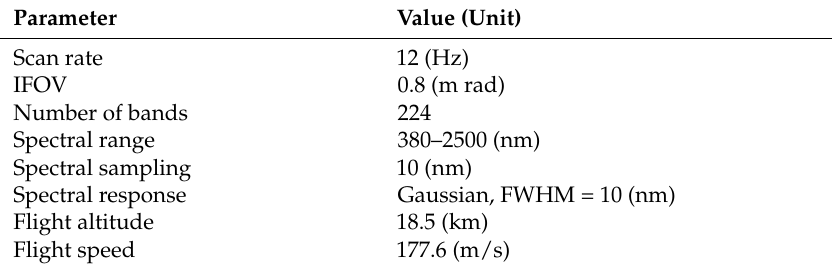
Table 3. The key DIRSIG configurations of AVIRIS-C